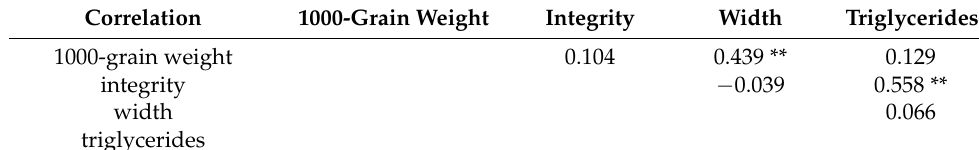
Table 2. Correlation analysis between 1000-grain weight, integrity, width, triglycerides.